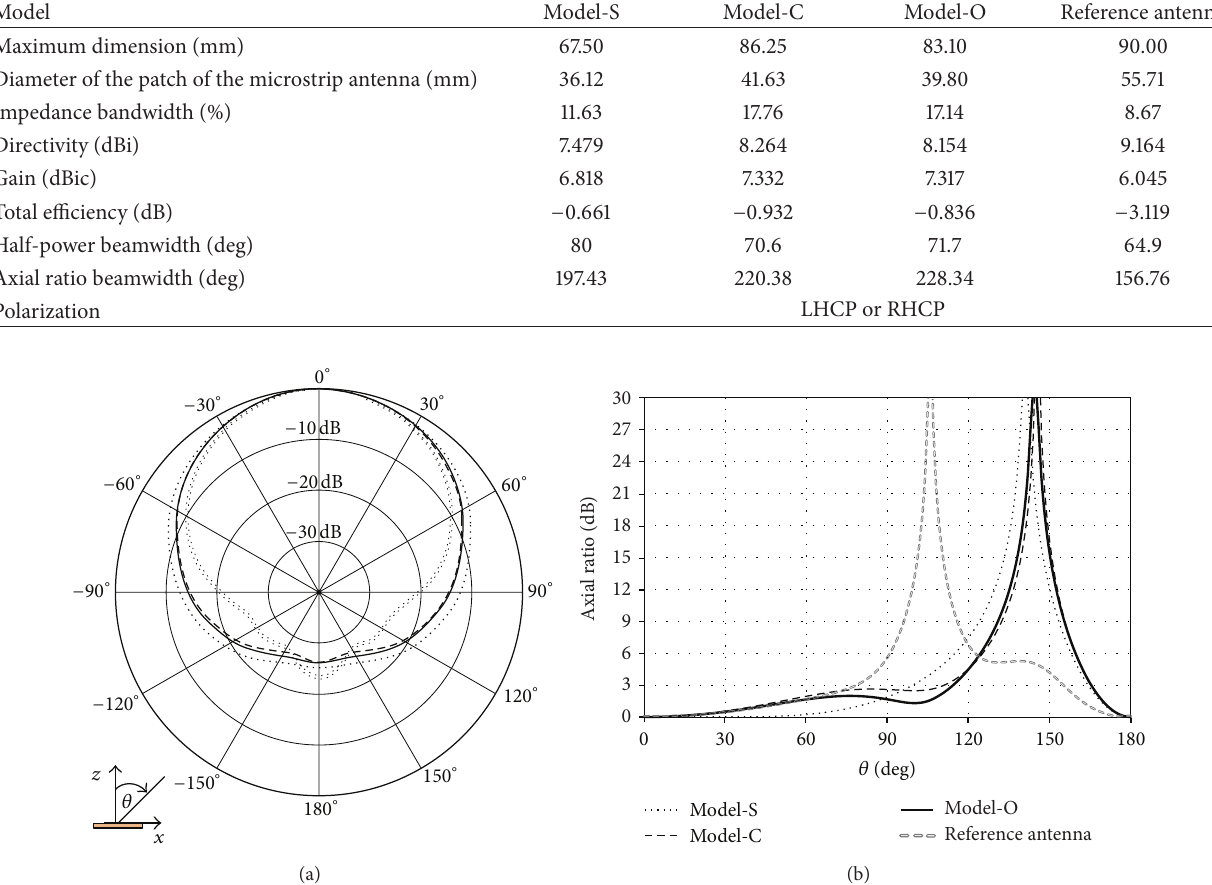
Figure 8: Simulated results of the radiation pattern and axial ratio of the circular microstrip antenna with AMC structures. (a) Radiation pattern. (b) Axial ratio.